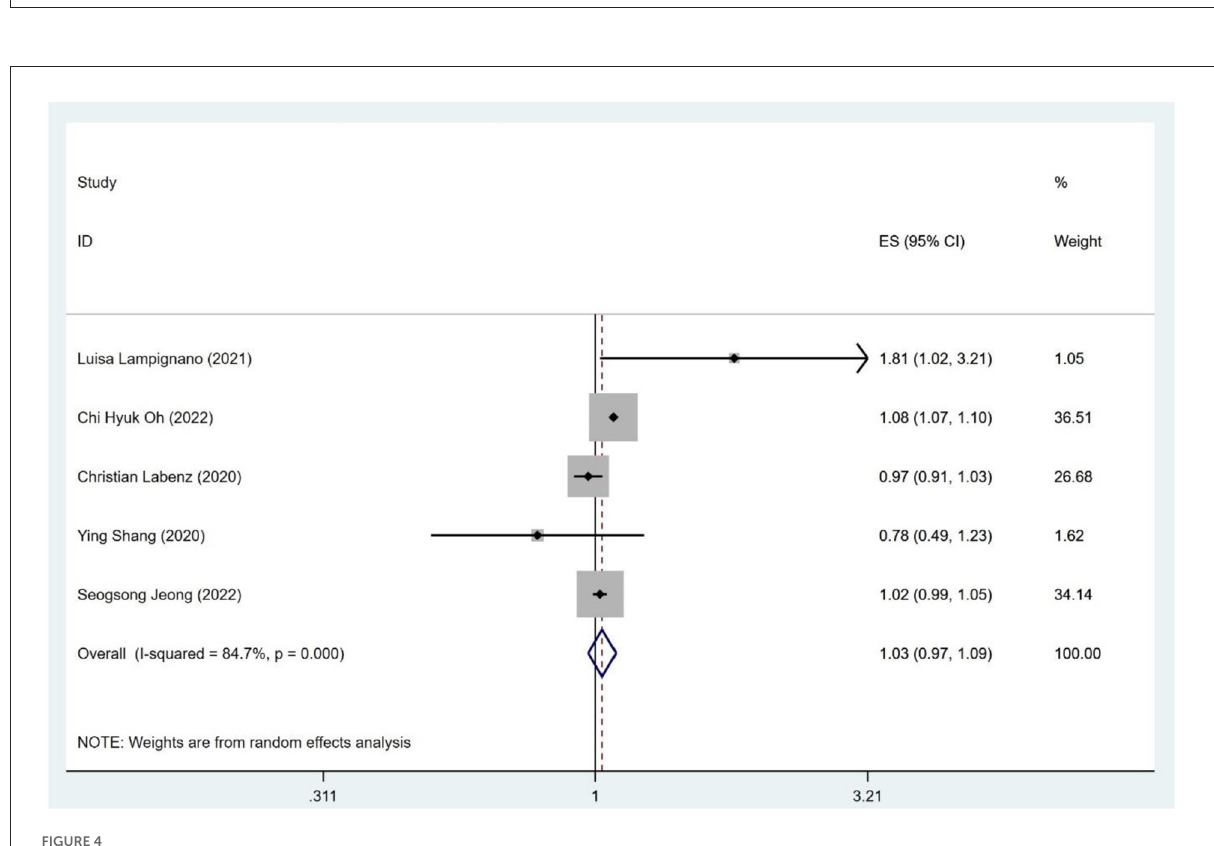
FIGURE4 Meta-analysis of the risk of dementia caused by